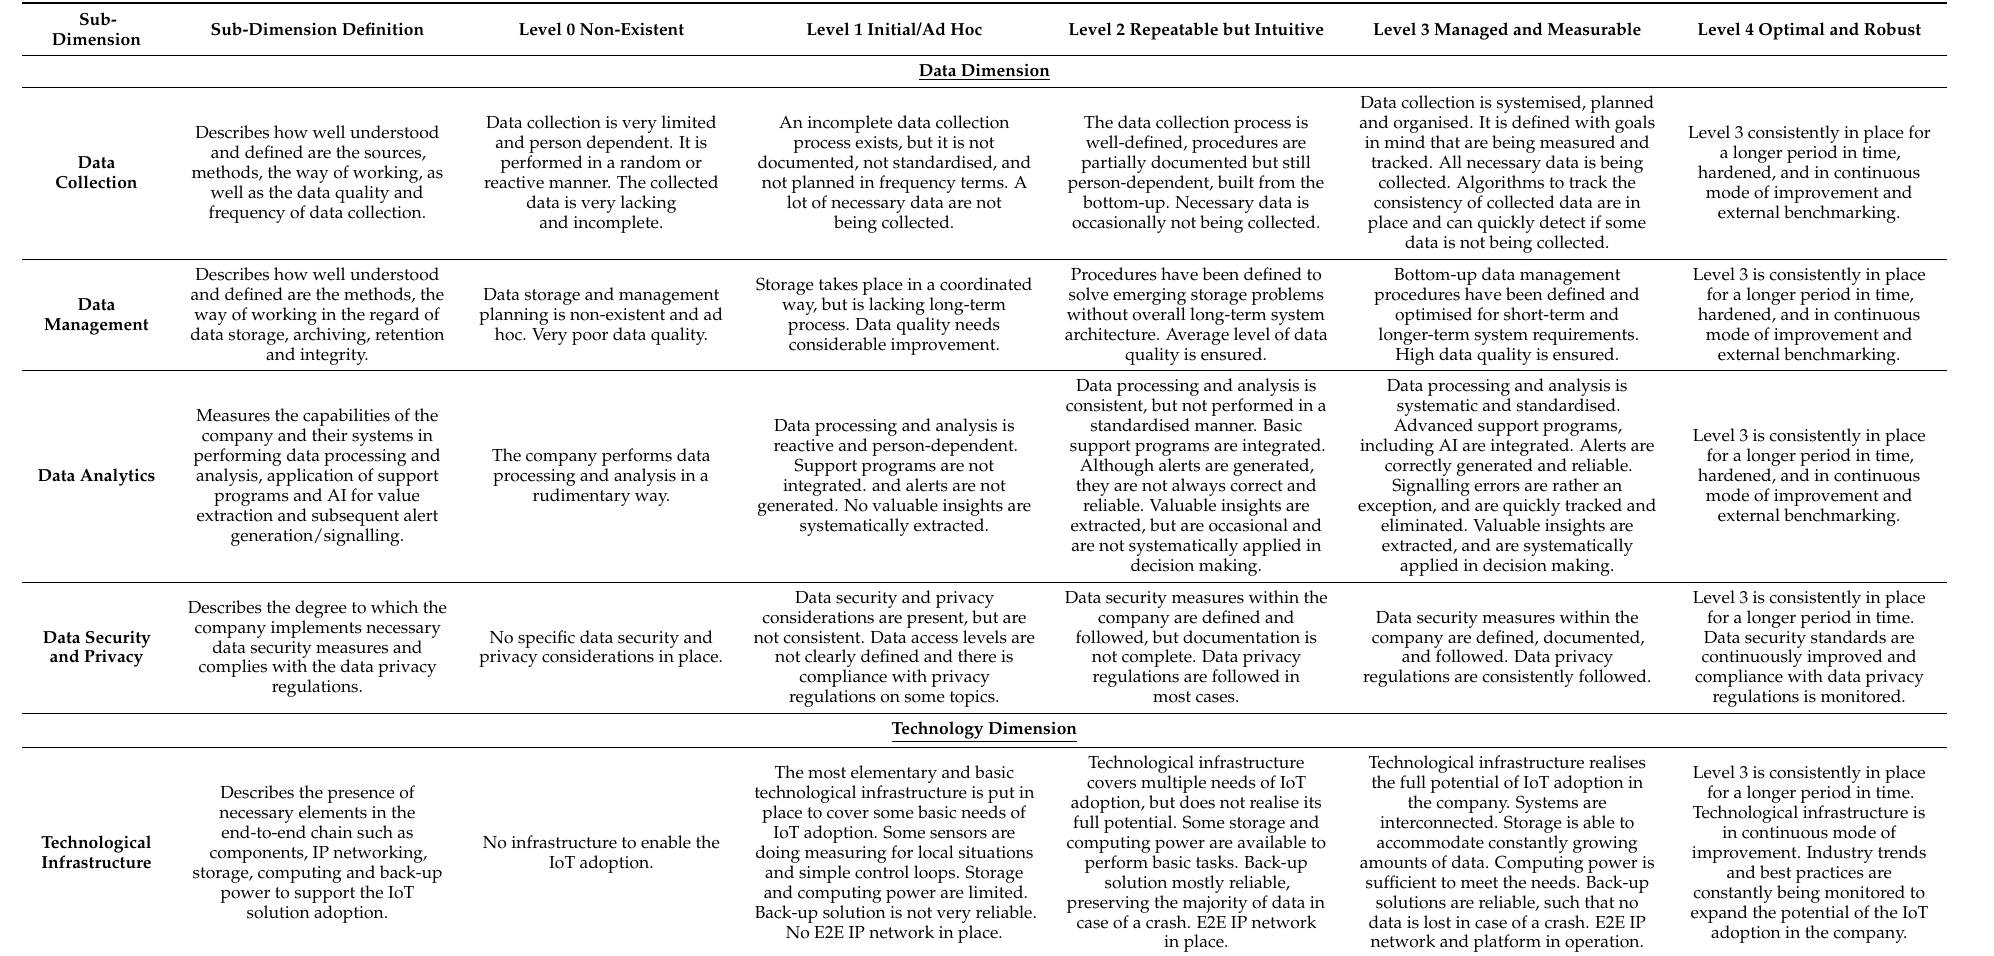
Table 2. Final maturity